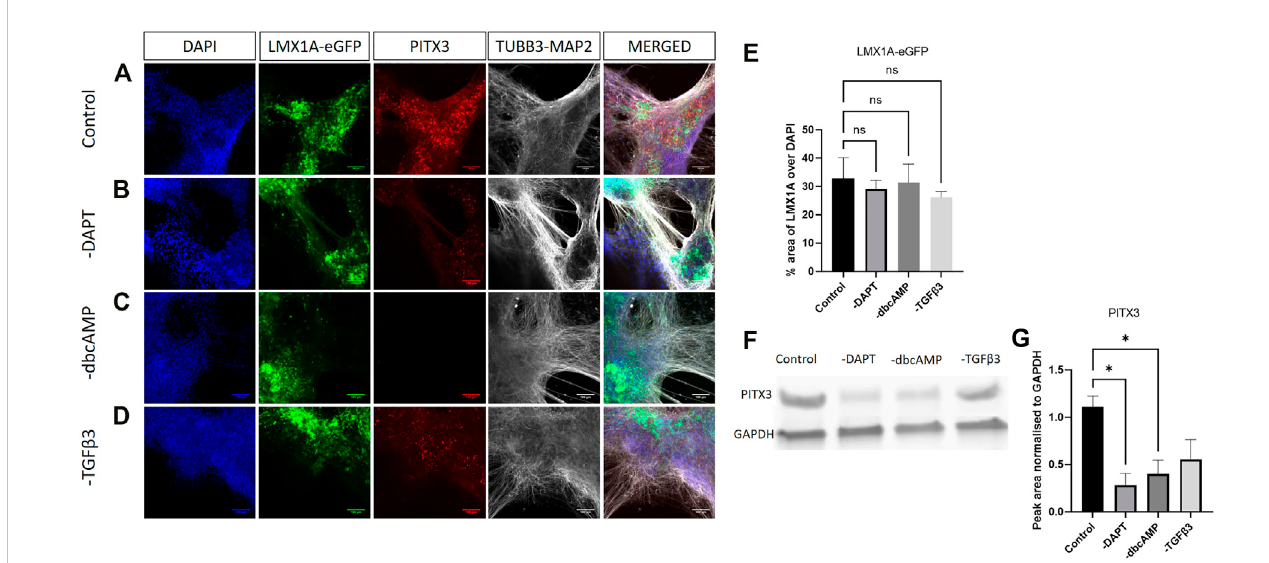
FIGURE 4 Immunolabelling of PITX3, TUBB3/MAP2 in LMX1A-eGFP cultures. Panel (A) shows, from left to right, DAPI nuclear labelling (blue), LMX1A-eGFP fl uorescence(green),PITX3(red)andTUBB3/MAP2inthesamechannel(white)andacolorcombinedimage(merged).Panels (B – D) showthecorresponding data, but following cultivation in the absence of DAPT, dbcAMP and TGF β 3, respectively. Scale bar indicates 100 μ m. Panel (E) shows LMX1A-eGFP fl uorescenceasafractionofDAPI fl uorescence( n =3).Panel (F) showsatypicalWesternblotwhilepanelGshowschangesinPITX3expressionfollowing removal of additives ( n = 3). Bar graphs show mean +/- s. e. mean; * = p <